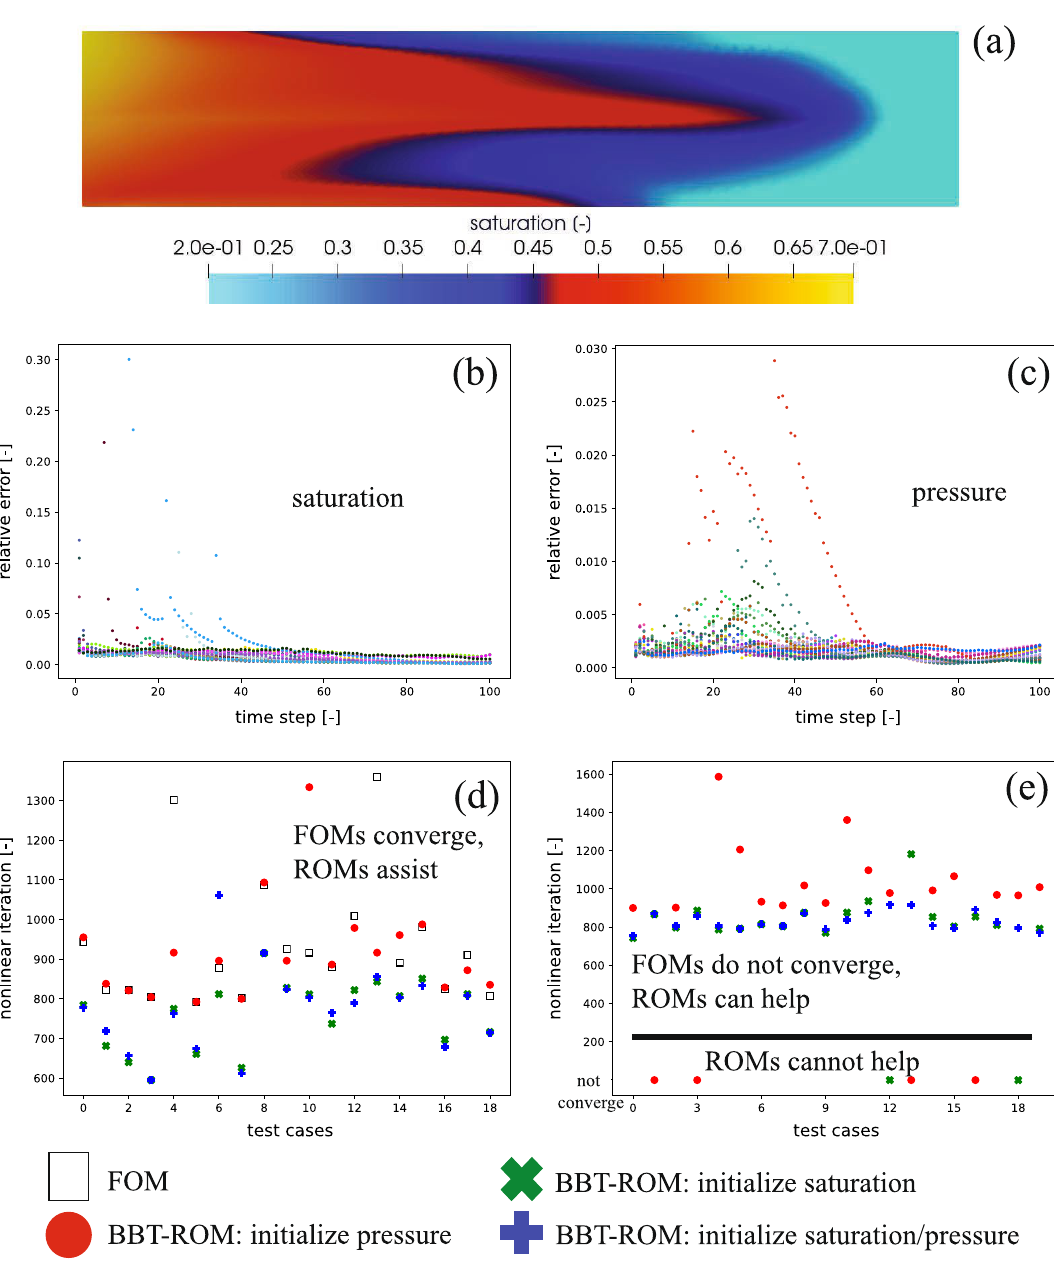
Figure 4. Example 3—results: ( a ) samples of test dataset results of κ top = 2.42 × 10 − 10 m 2 / Pa s at 50 days, ( b ) pressure ( p h ), ( c ) saturation ( s h )—relative error (see Eq. 3) of test dataset results, ( d ) number of nonlinear iterations for cases that the FOMs converge and we use BBT-ROM to speed up, and ( e ) number of nonlinear iterations for cases that the FOMs do not converge and we use BBT-ROM to improve the convergence. The nonlinear solver iteration using default FOM initialization, X h (cid:31) t n − 1 , µ ( i ) (cid:30) as an initial guess for X h (cid:31) t n , µ ( i ) (cid:30) , is shown with a black square, using BBT-ROM pressure initialization is shown with a red dot, using BBT- ROM saturation initialization is illustrated with a green cross, using BBT-ROM saturation and pressure initialization is presented with a blue plus. A number of nonlinear iterations here are an average over all t - 0 =: t 0 < t 1 < · · · < t N := τ for each µ ( i ) . The relative error (see Eq. 3) is calculated between FOM and BBT- ROM for each µ - κ top in this